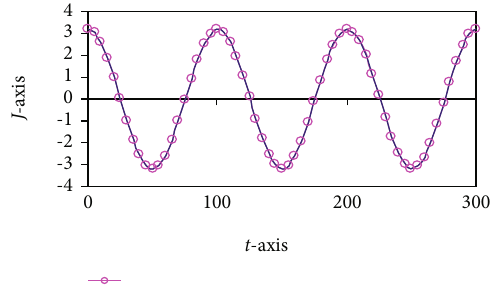
Figure 6: The analytical and numerical solutions J against the time t